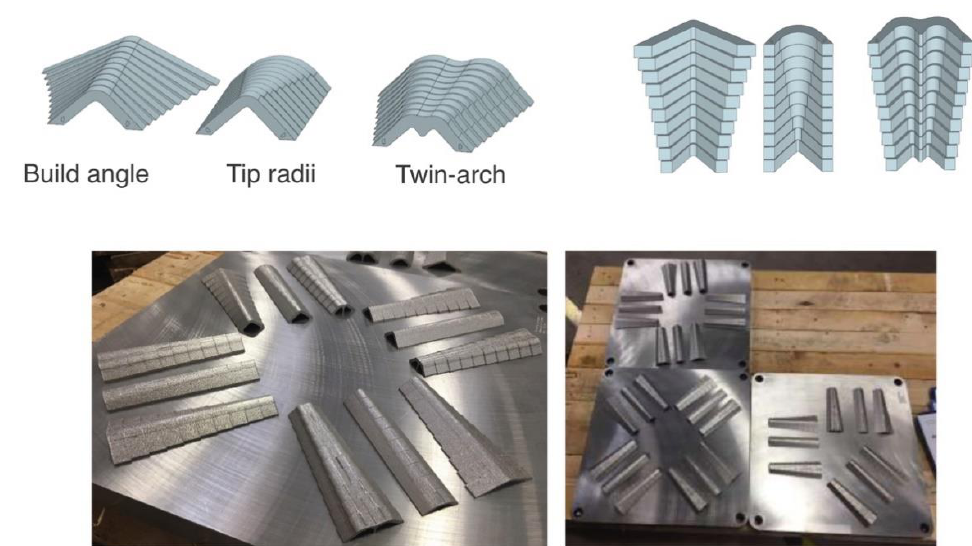
Figure 4. Example of design artefacts used to evaluate the capability of the laser powder bed fusion (LPBF) process to build the unsupported roof of the manifold. Specifically, impact of build orientation on manufacturability and design concepts and limits of the self-supporting roof were studied (courtesy of GKN Aerospace).